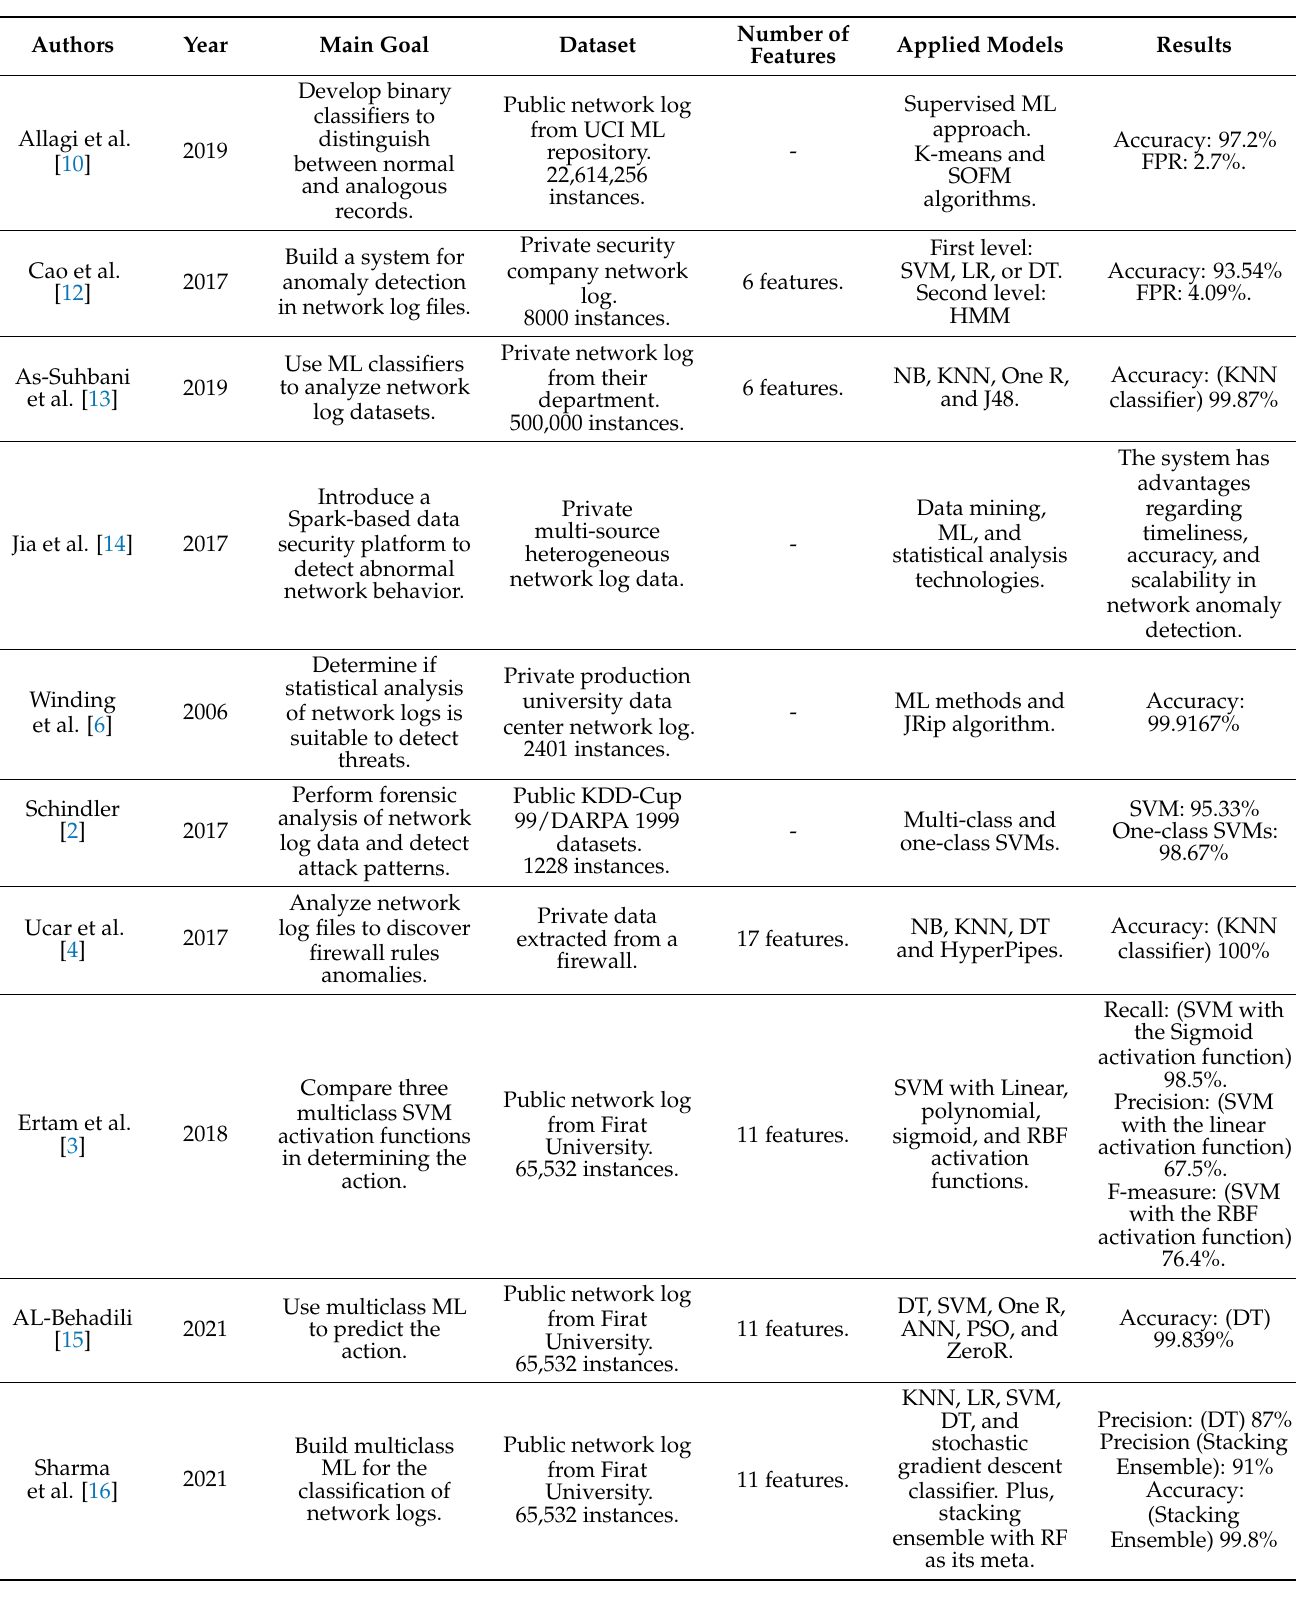
Table 1. Summary of the literature